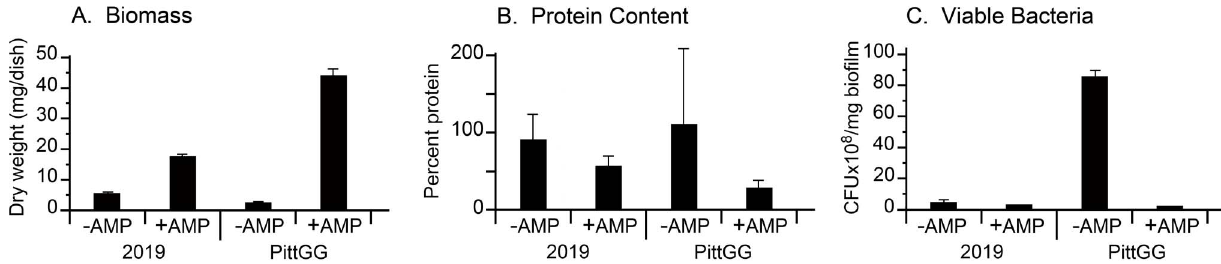
Figure 4. A sub-inhibitory concentration of ampicillin changes the composition of forming NTHi biofilms. Two strains of NTHi, 2019 and PittGG, exposed to sub-inhibitory concentrations (90 ng/mL: 2019; 170 ng/mL: PittGG) of ampicillin for 24 hr, showed increases in biofilm biomass as measured by dry weight (A. Biomass), and percent protein content (B. Protein Content). In contrast, the presence of the antibiotic during biofilm formation resulted in a decrease in viable (or culturable) bacteria (C. Viable Bacteria). Strain PittGG showed the most noticeable changes in dry weight, protein content and numbers of viable bacteria resulting from exposure to 170 ng/mL ampicillin (t-test p = , 0.05).